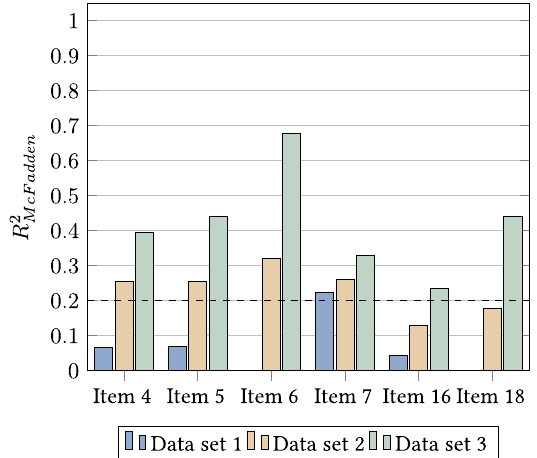
FIG. 3. Comparison of McFadden ’ s pseudo R 2 for intra-item prediction based on the different datasets. The limit from which good prediction quality can be assumed is shown as a dashed